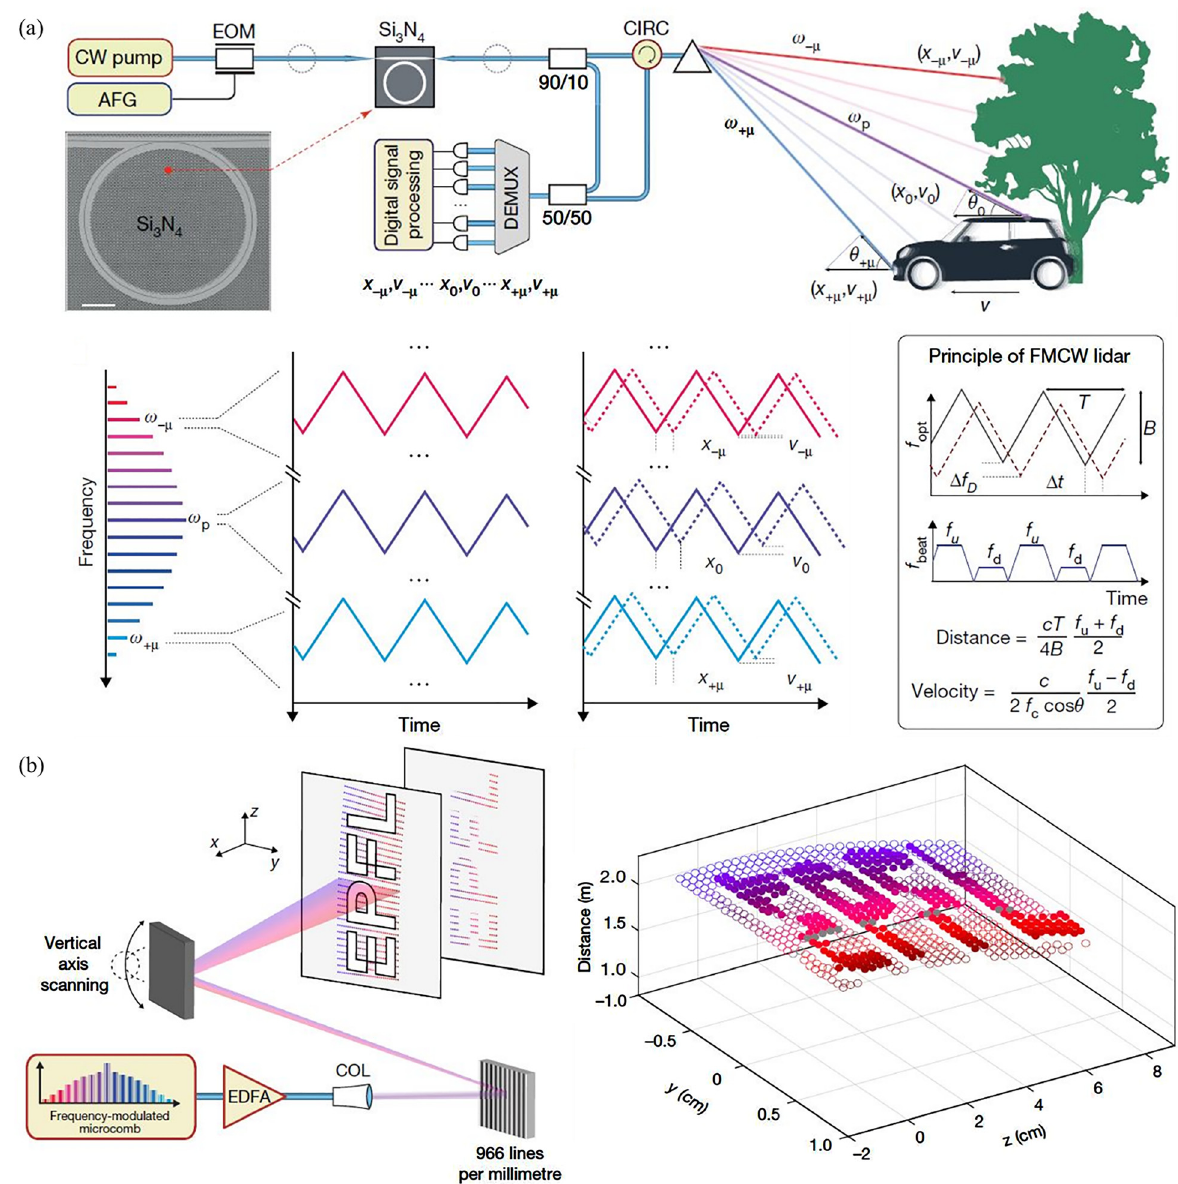
Figure 13: Optical frequency comb-based FMCW LIDAR for parallel sensing: principle, setup, and measurement result. (a) Top panel: Conceptual schematic of parallel FMCW LIDAR setup. The pump source is modulated by electro-optic modulator (EOM). The modulation signal is provided by an arbitrary functional generator (AFG). The modulated pump signal is injected into Si 3 N 4 microring for frequency comb generation. The inset shows the SEM image of integrated Si 3 N 4 micro-ring structure. Frequency comb lines are spread spatially by a dispersive optical component for parallel sensing along a line. The re fl ected signal enters circulator (CIRC) to beat with the original signal. The beat signal is split into separate comb line through a de-multiplexer (DEMUX), and converted into the electrical signal through a PD. Further signal processing are carried out to obtain the distance and velocity information at each point along the line. Bottom panel: Principle of FMCW LIDAR with each optical frequency comb line modulated for parallel sensing. (b) Left panel: experimental setup for paralleldistancemeasurement.Anexternalscanningmirrorisusedforverticalscanningofthefrequencycombsignal.Thetargetisformedby two pieces of papers. The front paper has been partially cut with “ EPFL ” logo. Right panel: 3D image plot based on the distance pro fi le measuredfromthetarget.(a)and(b)areadaptedwithpermissionfromSpringerNature,Nature[69].Massivelyparallelcoherentlaserranging using a soliton microcomb, by Riemensberger et al. Copyright